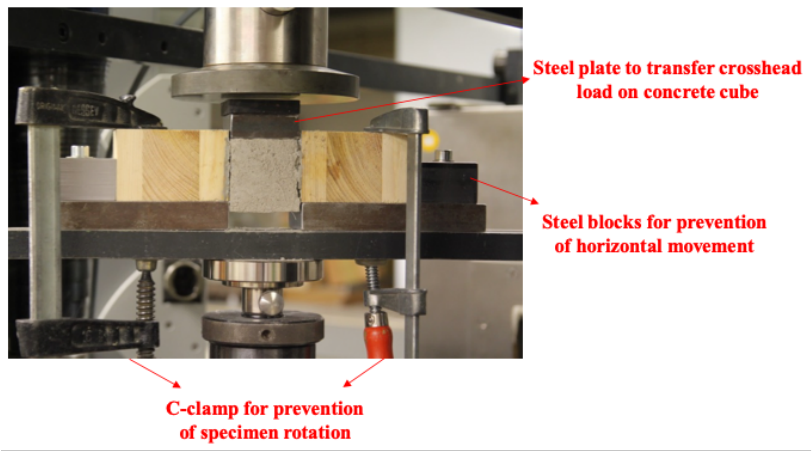
Figure 5. Shear test setup for measurement of shear strength of wet and dry